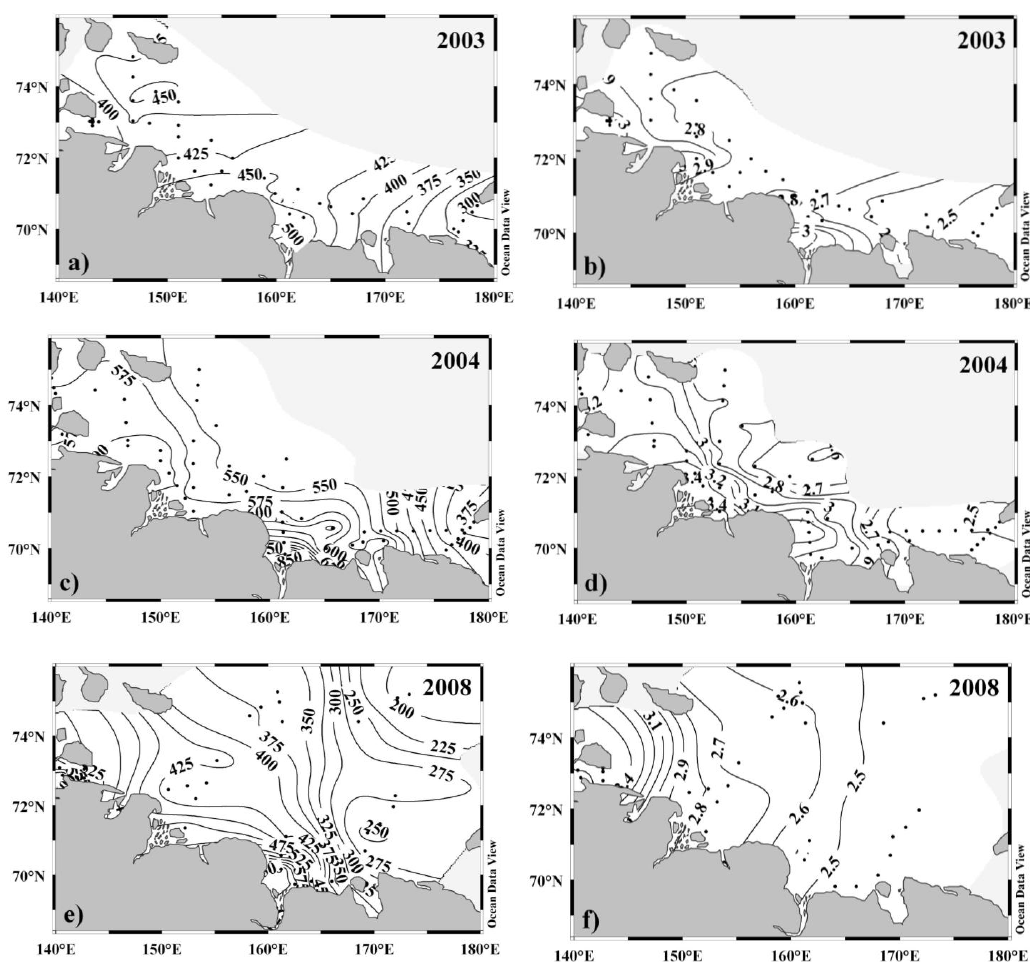
Fig. 8. Spatial distributions of surface water p CO 2 (µatm) (a, c, e) and normalized total alkalinity, nA T (mmolkg − 1 ) (b, d, f) , in the ESS during the 2003, 2004, and 2008